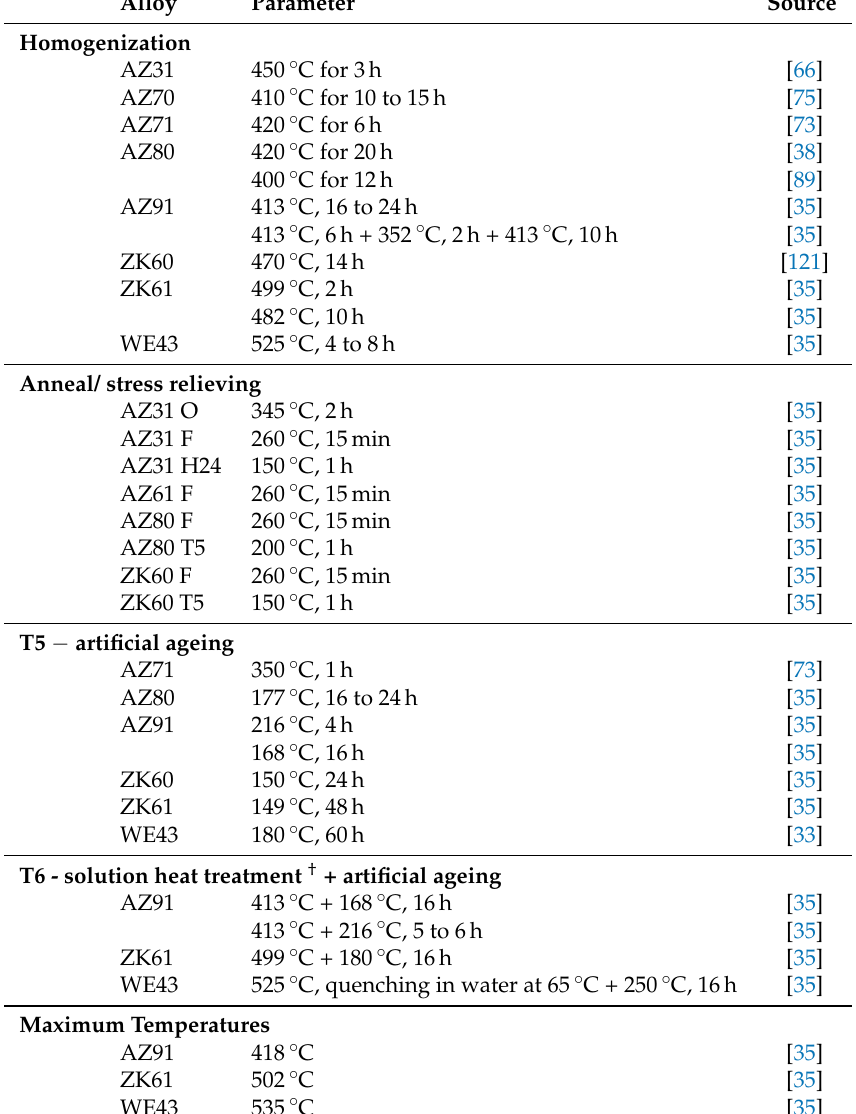
Table A4. Heat treatment parameters of various Mg alloys, based on recommendations from